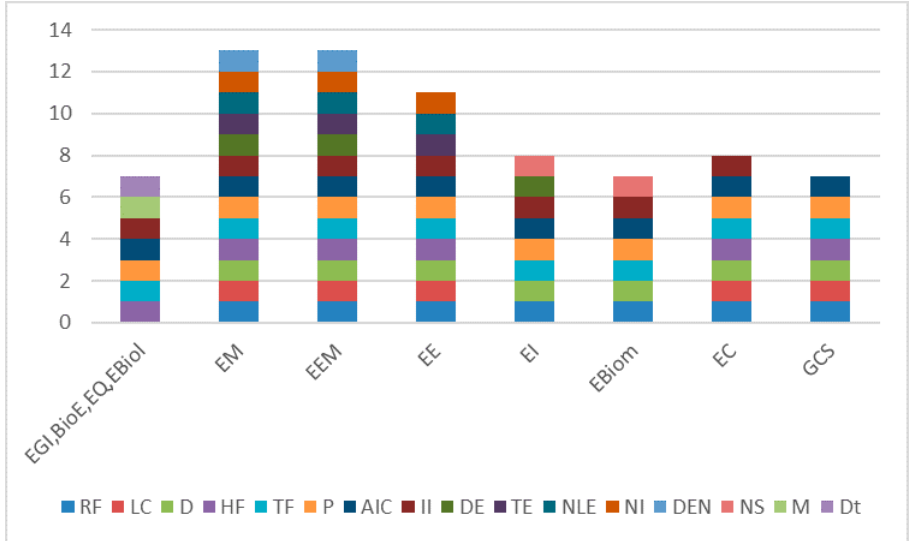
Figure 3. Programmed content distribution.